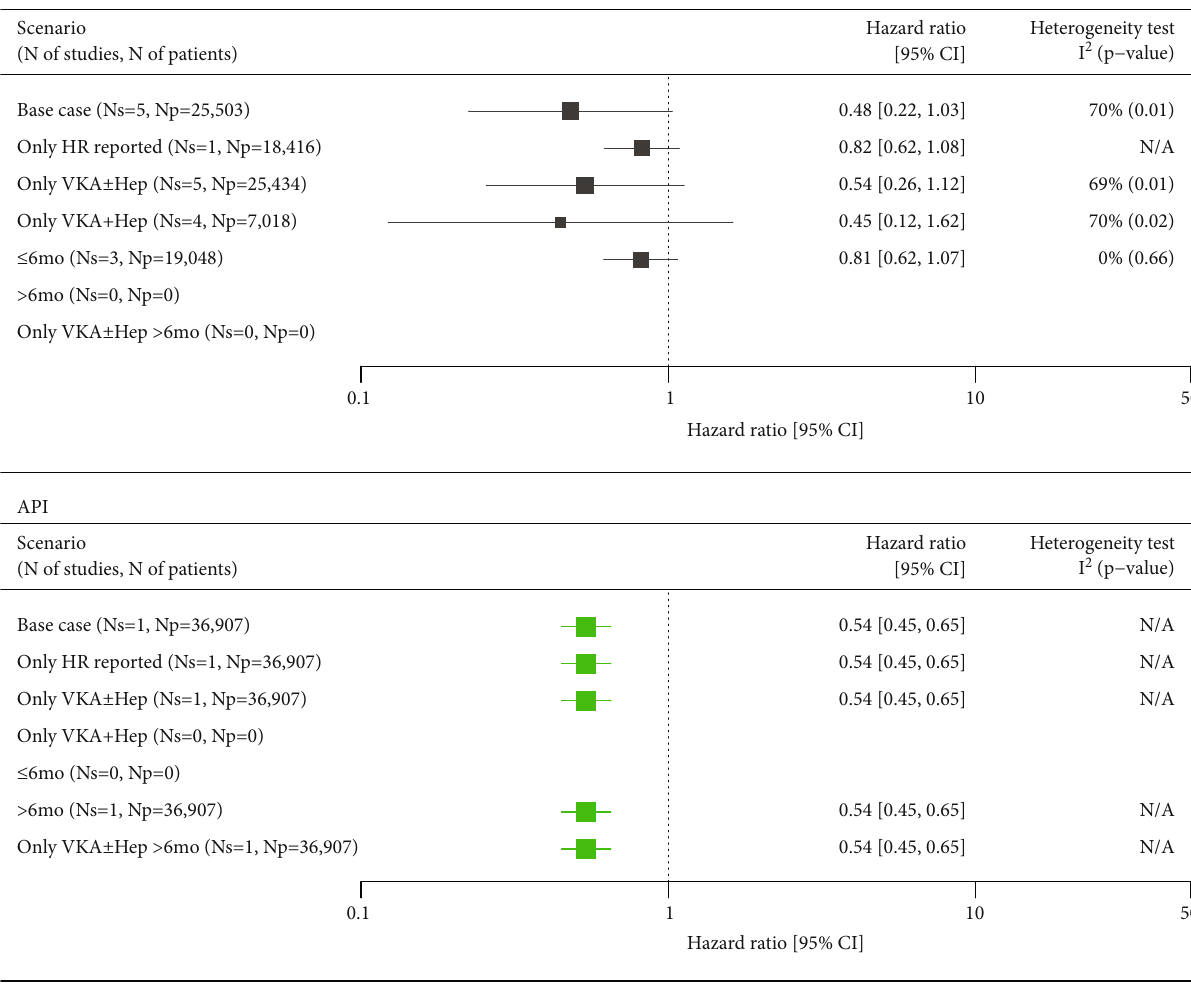
Figure 2: Summary of meta-analyses comparing RIV and API versus SoC in VTE for recurrent PE. API: apixaban; CI: con fi dence interval; HR: hazard ratio; Np: number of patients; Ns: number of studies; RIV: rivaroxaban; SoC: standard of care; VKA ± Hep: vitamin K antagonist ± heparins; VTE: venous thromboembolism; N/A: not applicable. Green marks represent results indicating statistically lower event rate in the NOAC